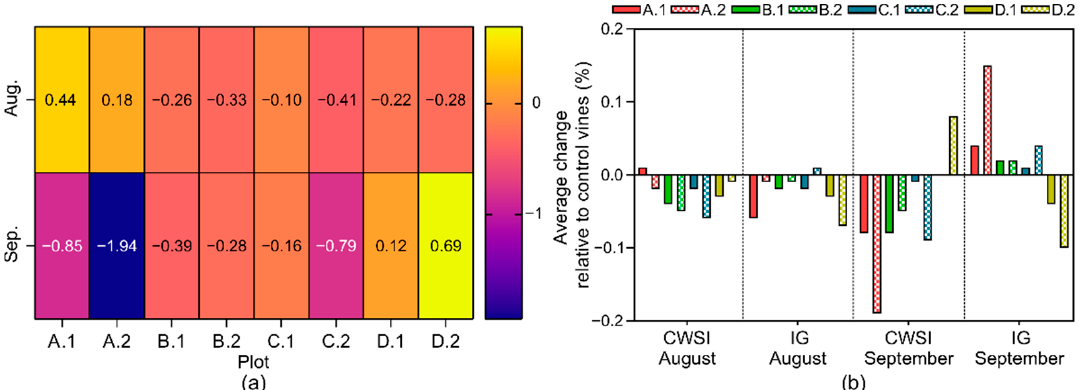
Figure 5. Relative difference of the canopy temperature (°C) ( a ) and of the estimated indices ( b ) from the grapevine vegetation in August and September in each plot. Data represents the average change of kaolin-treated plants relative to control vines of Touriga Nacional . CWSI: crop water stress index; IG: stomatal conductance index.